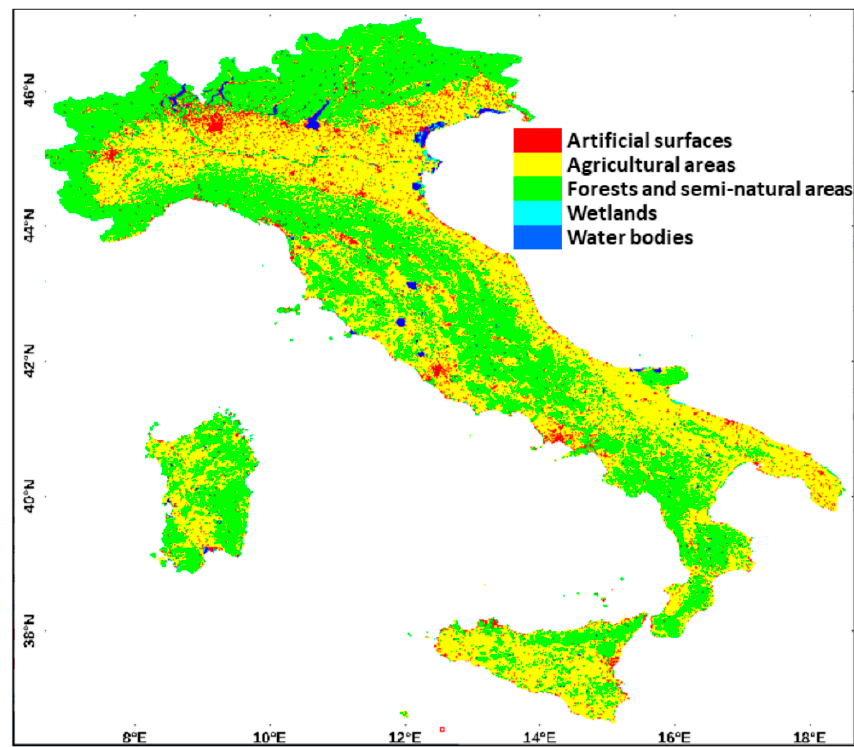
Figure 2. Land cover map of Italy derived from the CORINE land cover (CLC) data (projection LATLON-WGS84). Red: artificial surfaces (codes from 111 to 142); yellow: agricultural areas (211 to 244); green: forests and semi-natural areas (311 to 335); cyan: wetlands (411 to 423); blue water bodies (excluded sea; 511 to 522). It represents the master product used by AUTOBAM as a geographic reference for cartographic projection and pixel size.